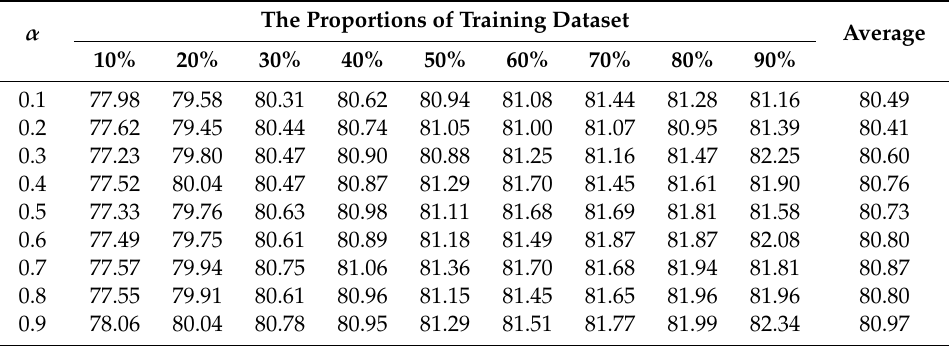
Table 8. Influence of triplet weight on the DBLP